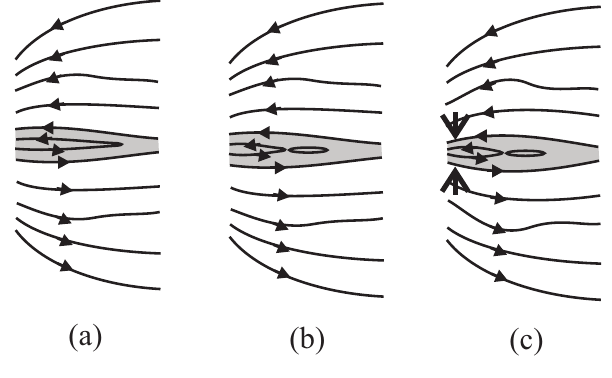
Fig. 3. (a) Equilibrium thin plasma sheet with current-carrying dense hot plasma, on a uniform cold low density background. (b) The sheet after a localized burst of nonlinear tearing instability – impulsive reconnection. The topology has changed: a magnetic island has appeared. (c) CS thinning by means of a MHD pulse escaping the reconnection zone over the plasma of tail lobes. The equilibrium in x-direction in the thinning zone is